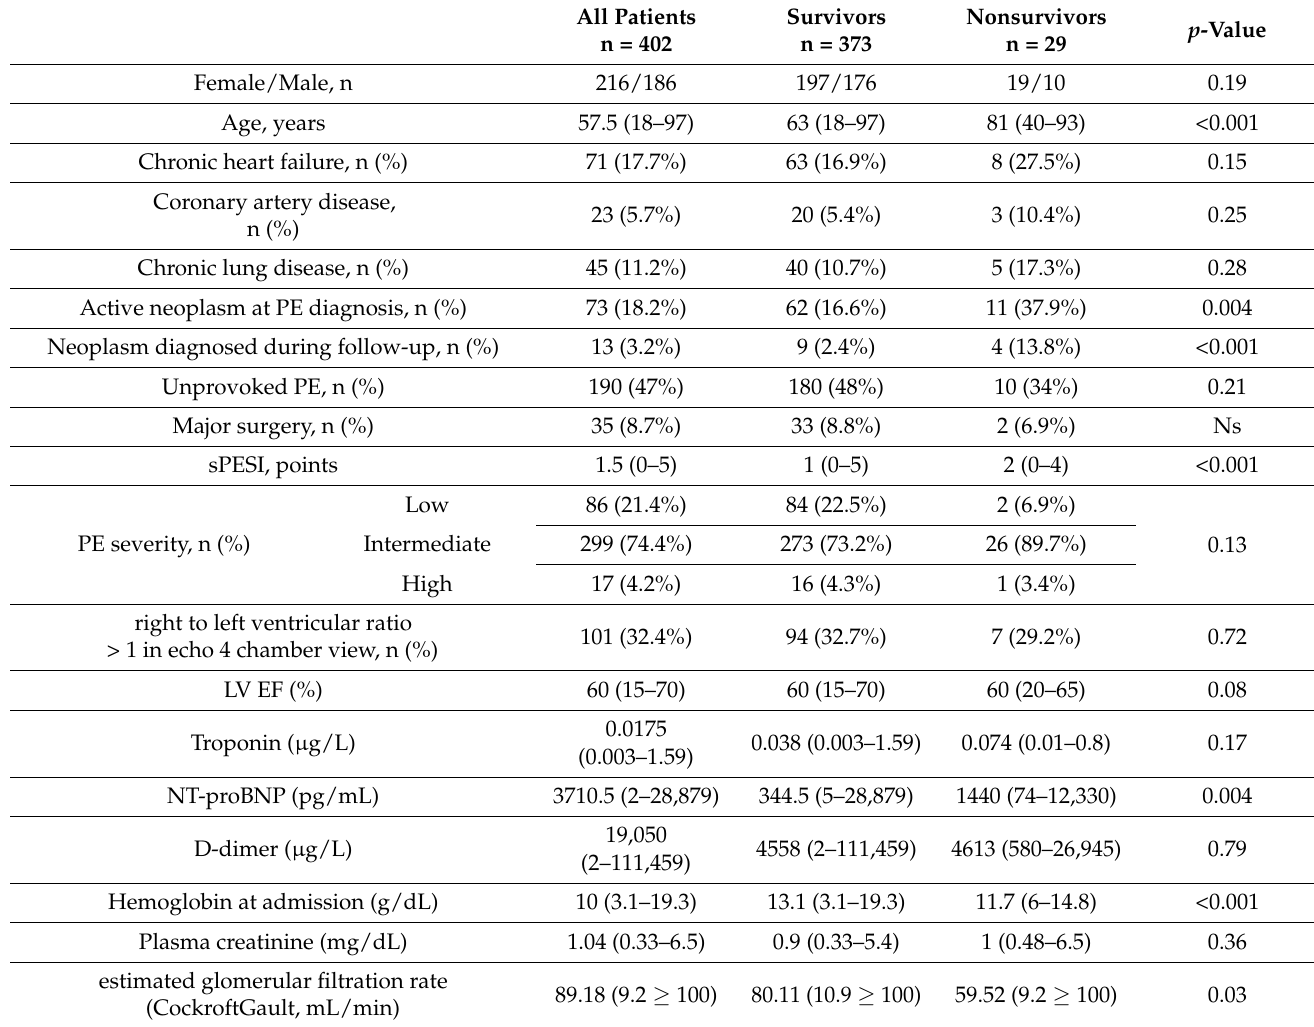
PE—pulmonary embolism, sPESI simplified Pulmonary Embolism Severity